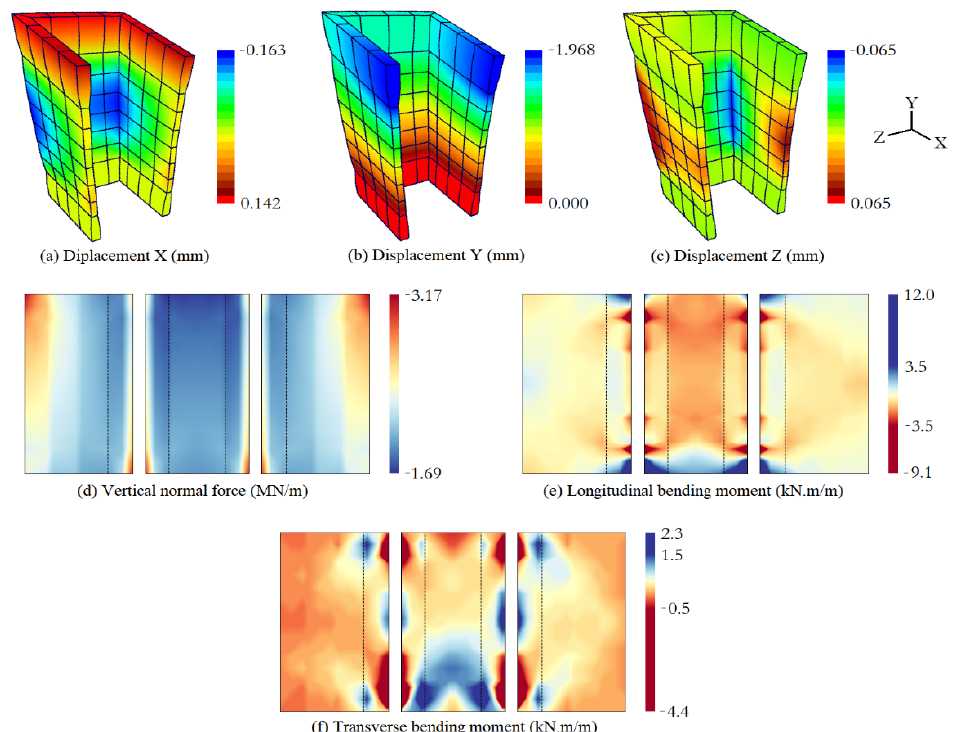
Figure 12. U-shaped shear wall displacements and internal forces diagrams